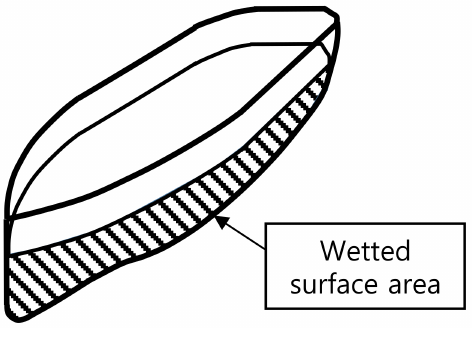
Figure 1. Wetted surface